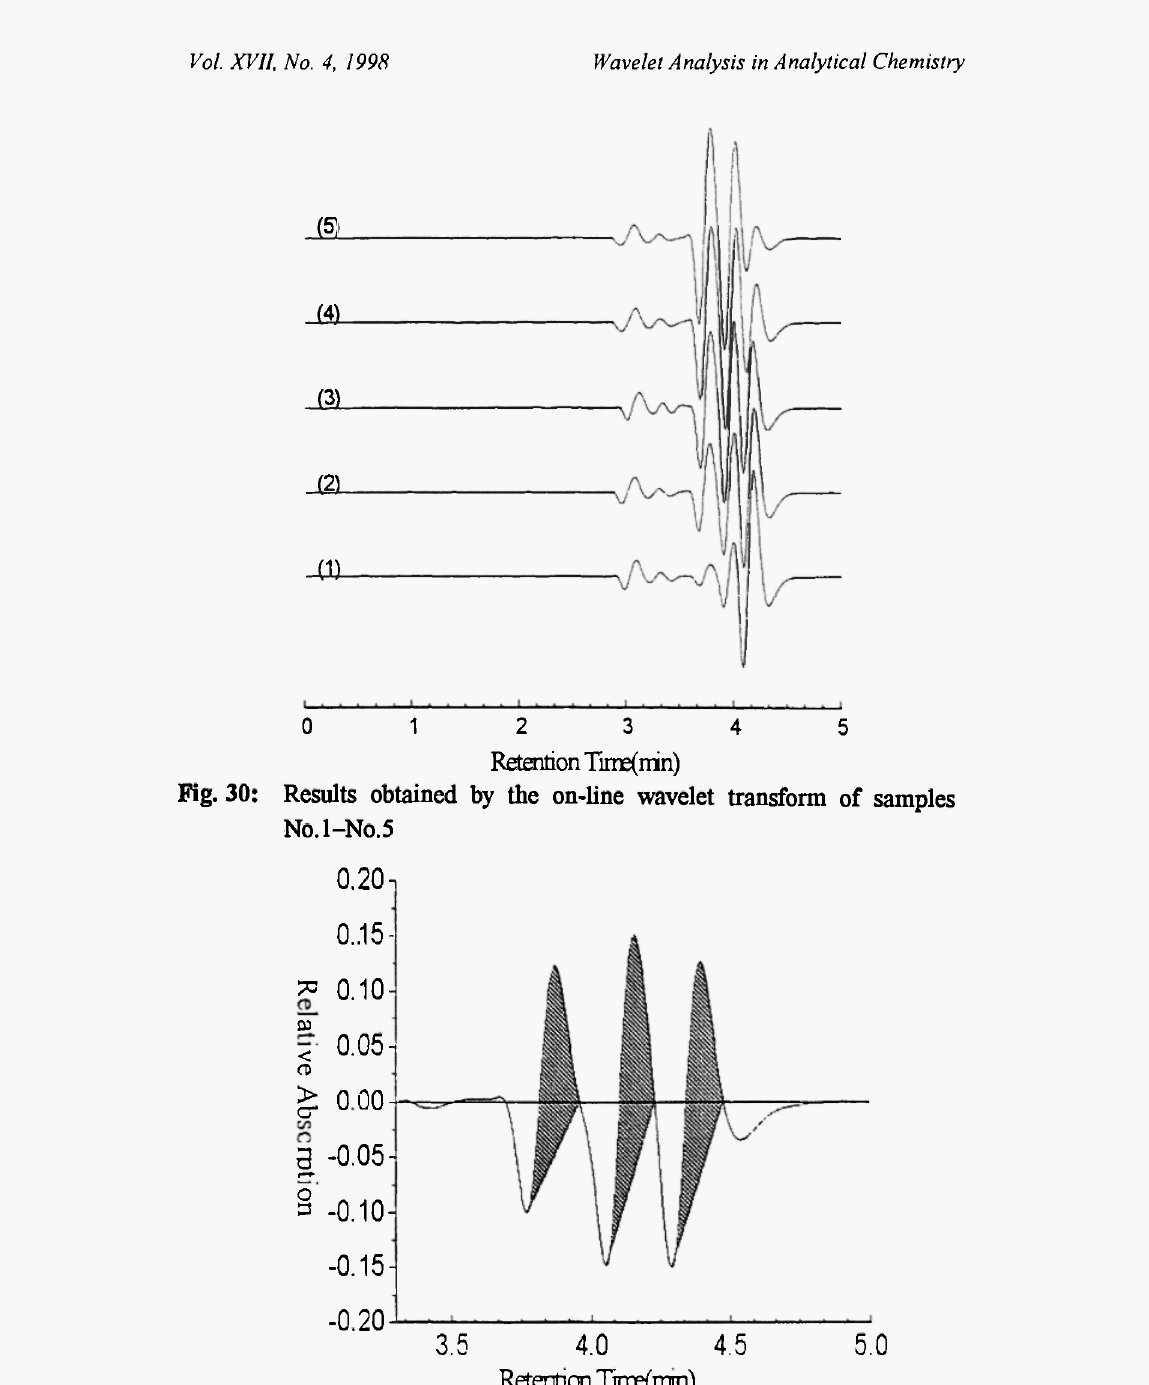
Fig. 31: The diagram showing the calculation of the area from the resolved